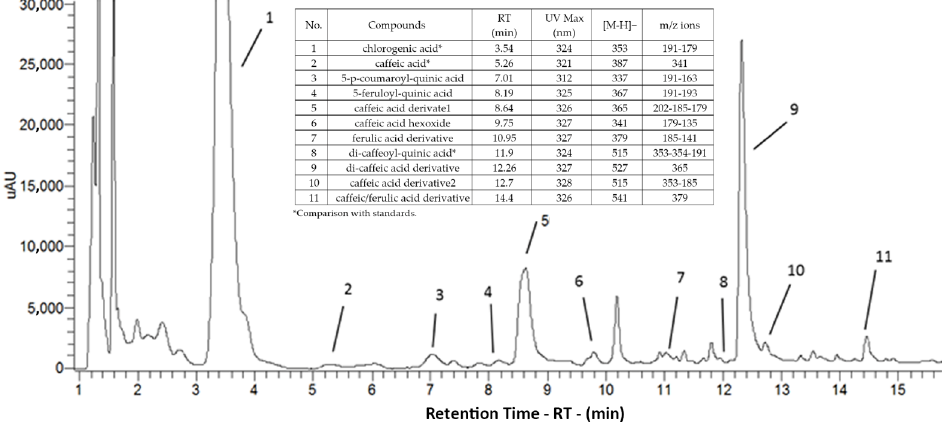
Figure 1. UHPLC chromatogram of peels of ‘Carota a punta lunga’ landrace phenolic compounds. In peeled carrots, irrespective of genotype, the most abundant compounds were chlorogenic acid followed by 5-p-coumaroyl-quinic acid, while all other phenolic com- pounds were in amounts lower than 1 mg kg − 1 fw. The root flesh of ‘Presto’ and particu- larly of the landrace CPT contained the highest level of total phenolic compounds ( p ≤ 0.05) (specifically, chlorogenic and 5-p-coumaroyl-quinic acids). Averaged over genotypes, chlorogenic acid in peel was followed by di-caffeic acid derivative, caffeic acid derivative 1, 5-p-coumaroyl-quinic acid, ferulic acid derivative, and caffeic/ferulic acid derivative. All other phenolic acids were in amounts lower than 1 mg kg − 1 fw. By considering the genotype effect, it emerged that the peel of ‘Presto’ had the lowest concentration ( p ≤ 0.05) of phenolic acids, while both landraces were 23-fold richer in comparison to the hybrid due to the contribution of chlorogenic acid and di-caffeic acid derivative ( p ≤ 0.05). In previous works, a decreasing phenolic acid concentration was found passing from peel to cortex (3.2 times lower) and core (9.5 times lower) [11]. Moreover, hand peeling proved to appreciably reduce the total and individual phenolic acid content in compari- son with the intact roots [10,12,13]. However, this latter research did not take into account the effect of genotype on phenolic acid partition in carrot roots. For the “yellow-purple Polignano carrot” landrace and a commercial genotype grown in the Puglia area, both anthocyanin and phenolic acids accumulation were also registered in the cortex (including the periderm) at double the rate compared to the core portion [20]; however, the comparison between varieties for phenolic acid content is not reported. Our results confirm a higher concentration of phenolic acids in the peel (Table 6); however, they allow us to highlight that it was true only for the landraces. These latter showed a huge change of phenolic acid concentration between the peel and the root flesh (130.8 vs. 12.9 mg kg − 1 fw, on average); in contrast, phenolic acid concentrations seem